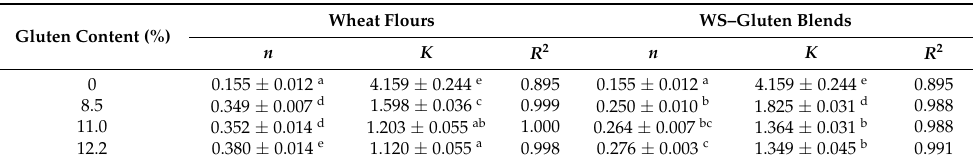
Table 1. Flow behavior index ( n ), fluid consistency index ( K ) during increasing shear rate for the film-forming matrices of pure WS, wheat flours, and WS – gluten blends with different gluten content (8.5%, 11.0%, and 12.2%) at 25 °C. Gluten Content (%)